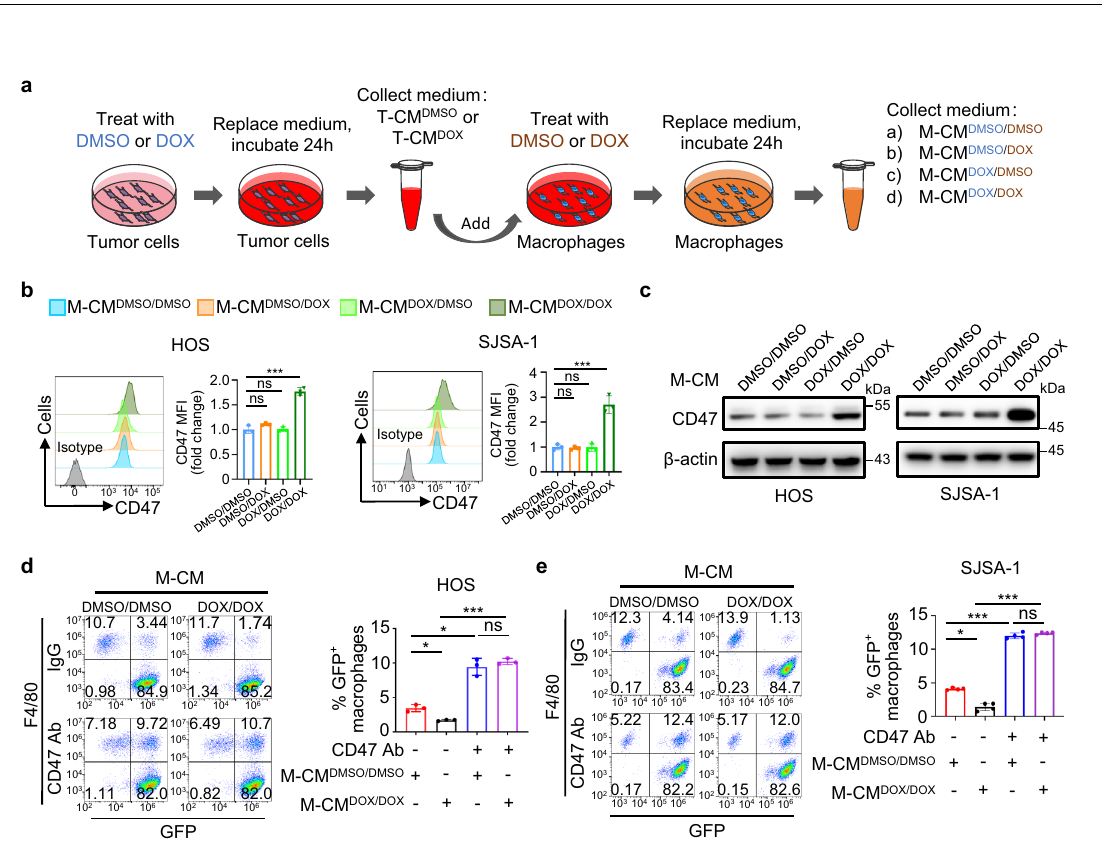
Fig. 3 | Macrophage-secreted factors induced by doxorubicin promote CD47 expression in osteosarcoma cells for inhibition of macrophage phagocytosis. a Schematic diagram of producing macrophage-conditioned media (M-CM). HOS cells were treated with DMSO or doxorubicin (DOX) to produce DMSO-treated tumor-conditioned medium (T-CM DMSO ) or DOX-treated tumor-conditioned med- ium (T-CM DOX ).THP-1-cell-derived macrophages were treatedwith the T-CM DMSO or T-CM DOX in the presence of DMSO or DOX to produce four kinds of M-CM: M-CM DMSO/DMSO wasproduced after treated with T-CM DMSO and DMSO; M-CM DMSO/DOX was produced after treated with T-CM DMSO and DOX; M-CM DOX/DMSO was produced aftertreatedwithT-CM DOX andDMSO;M-CM DOX/DOX wasproducedaftertreatedwith T-CM DOX and DOX. b , c HOS or SJSA-1 cells were treated with M-CM DMSO/DMSO , M-CM DMSO/DOX ,M-CM DOX/DMSO ,orM-CM DOX/DOX for24h. b CD47expressiononthecell surface was determined by fl ow cytometry using isotype control or anti-CD47